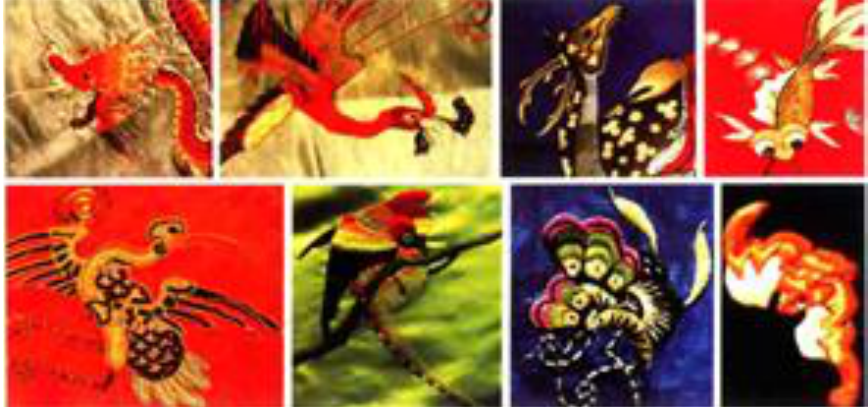
Figure 1. Animal patterns (The picture from Chinese Shu embroidery)